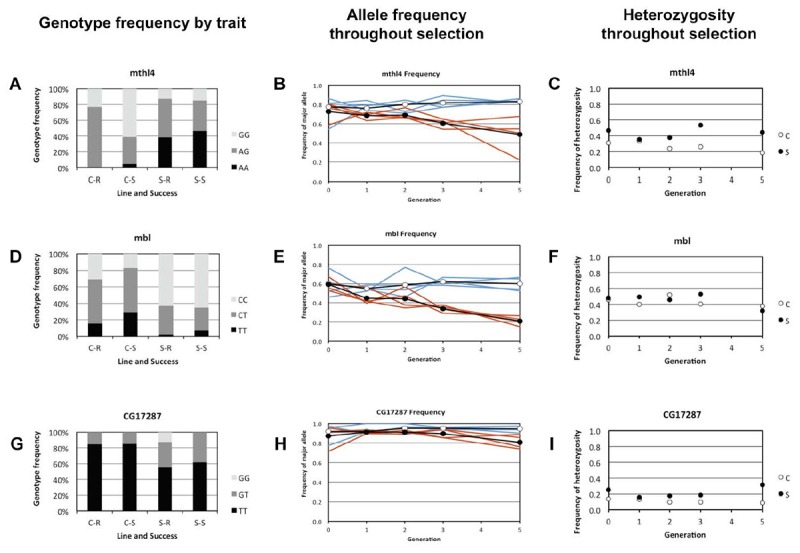
Genotype, allele, and heterozygosity frequencies for the genes that showed a significant association between genotype and resistance ability in the Selection and Control lines. Control lines are in blue and the Selection lines in red. Panels (A,D,G) show the depict genotype frequencies in resistant and susceptible larvae of the Selection and Control lines for mbl, mthl4 and CG17287, respectively. For both the Selection (S) and the Control (C) lines, the genotype frequencies are shown separately for resistant (R) and susceptible (S) larvae. Panels (B,E,H) show the frequency of the major allele for each generation of selection, pooling the four replicate lines for each selection regime. Open circles denote the average of the control treatment and closed circles the average of the selection treatment. Separate trajectories for these alleles are shown for each Selection line (in red) and Control line (in blue). Panels (C,F,I) show the frequency of heterozygotes in each generation of selection (pooled per selection regime).